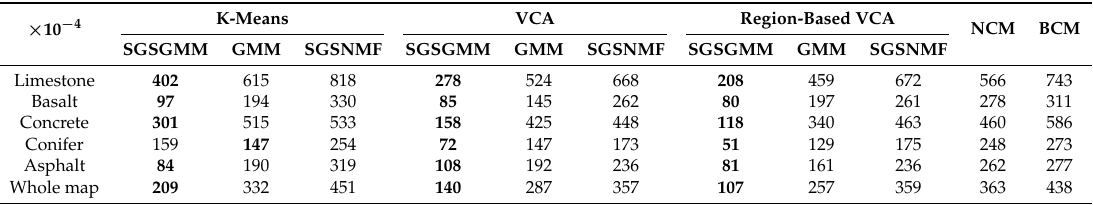
Figure 14. The scatter plot of the synthetic dataset under different initial conditions. The gray dots are the pixels when projected by PCA. ( a ) The original endmember scatter plot of the synthetic dataset with estimated GMM. ( b ) The endmember scatter plot by K-means initialization. ( c ) The endmember scatter plot by VCA initialization. ( d ) The endmember scatter plot by region-based VCA initialization. Table 7. Abundance errors for synthetic dataset under different initialization